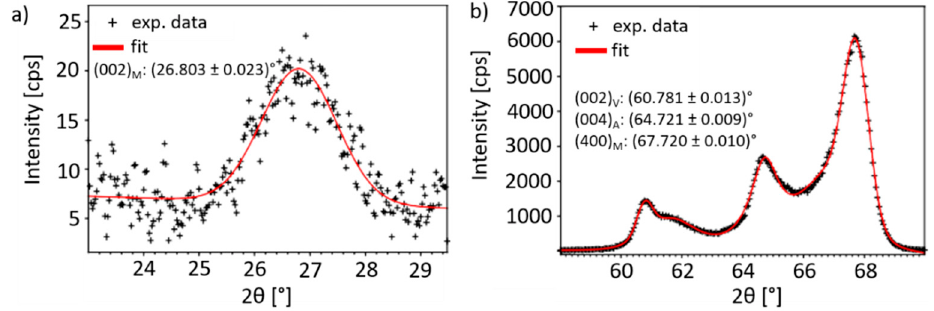
Figure 5. θ /2 θ -scan measured at room temperature for the ( a ) (002) M peak and ( b ) (004) A and (400) M peaks and the correspondent fits.